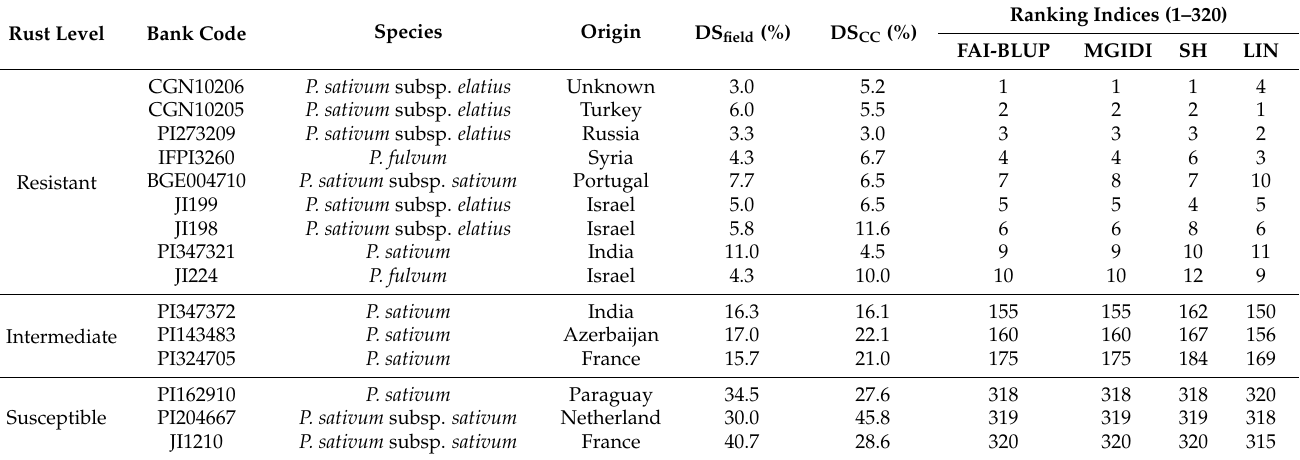
Table 4. Selected accessions representing three rust response levels (partial resistant, intermediate, and highly susceptible) through multi-trait index approach (FAI-BLUP, MGIDI, Smith-Hazel (SH), and Lin-Bin (LN), respectively).